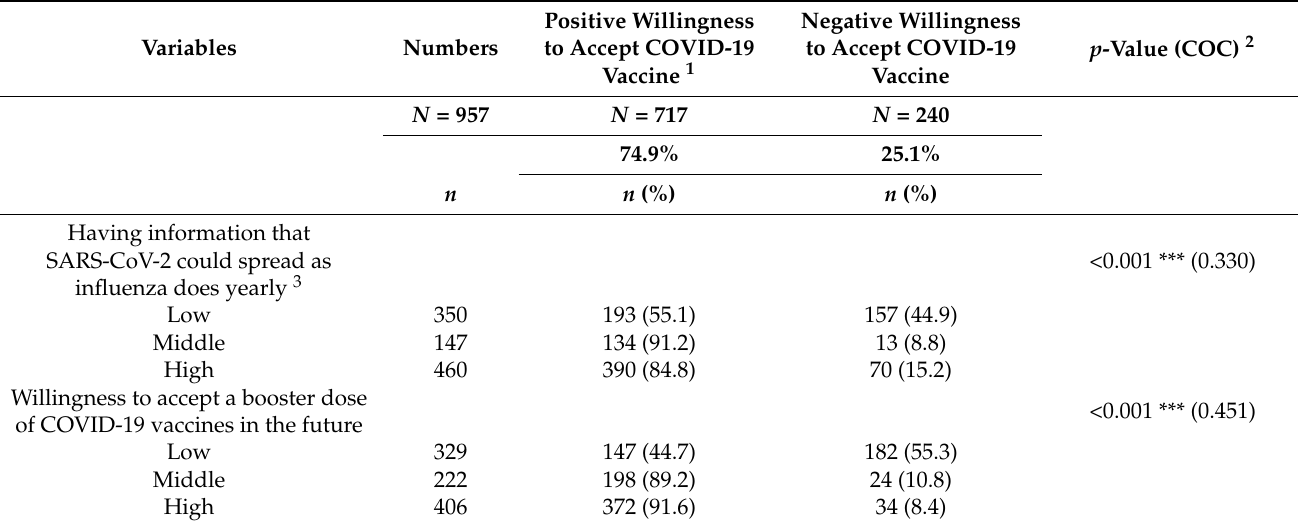
Table 4. Knowledge of the COVID-19 pandemic and attitudes toward accepting booster doses of COVID-19 vaccines.